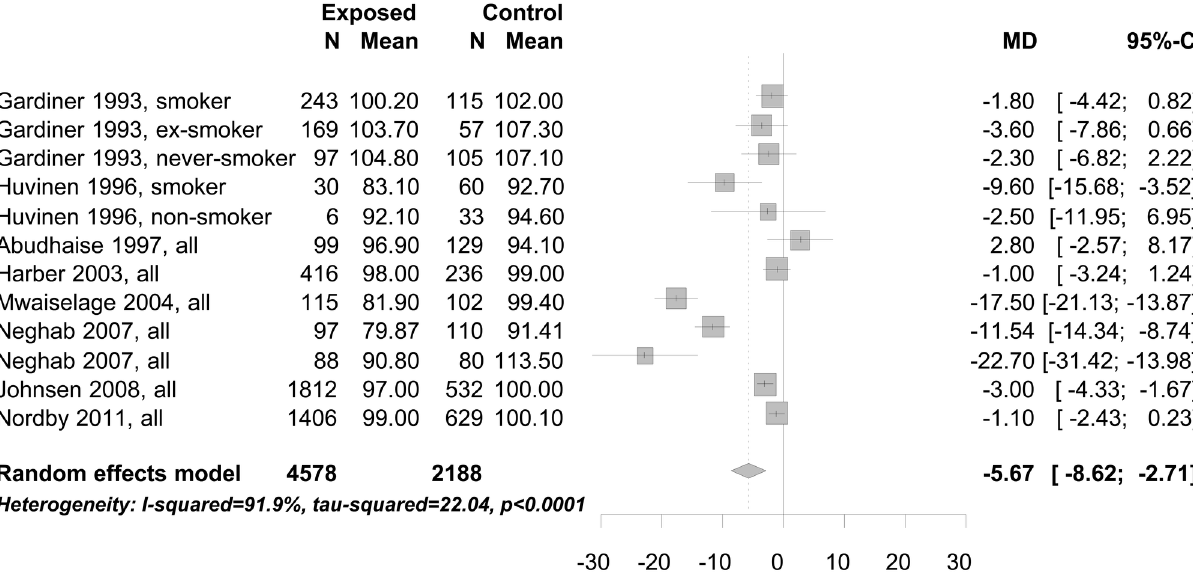
Figure 3. Mean difference (MD) of FEV1 in % predicted between study participants exposed to bg dust at the workplace and no/low exposed